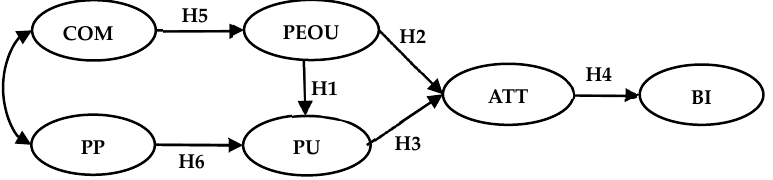
Figure 1. Research model and hypotheses.